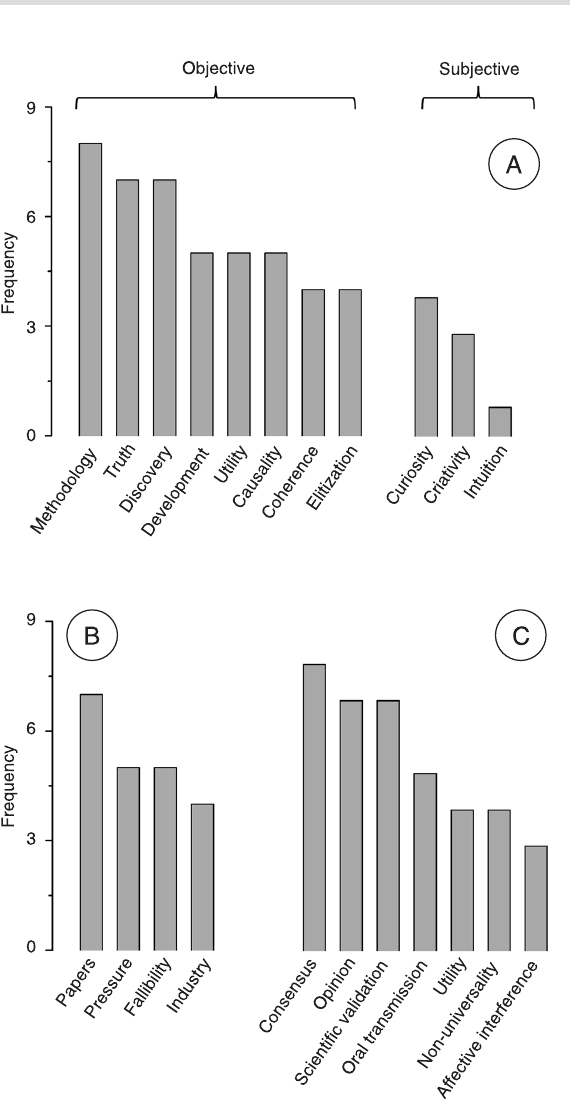
Figure 2. Frequency of the themes mentioned by the MD-PhD stu- dents during the semi-structured interviews related to the objective and subjective aspects of scientific thought ( A ), production of sci- entific knowledge ( B ) or common sense ( C ). The content of the in- terviews was subdivided into 22 thematic groups using the Science and Common Sense Concept (SCSC) inventory, and compared with published statements about concepts of science and common sense enunciated by well-known philosophers and